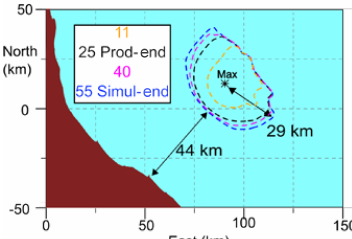
Figure 6. Maps with time evolution of 2cm iso-subsidence line. At simulation-end (30 years after the production-end), minimum distance from coastline and maximum areal extent of the subsidence bowl.